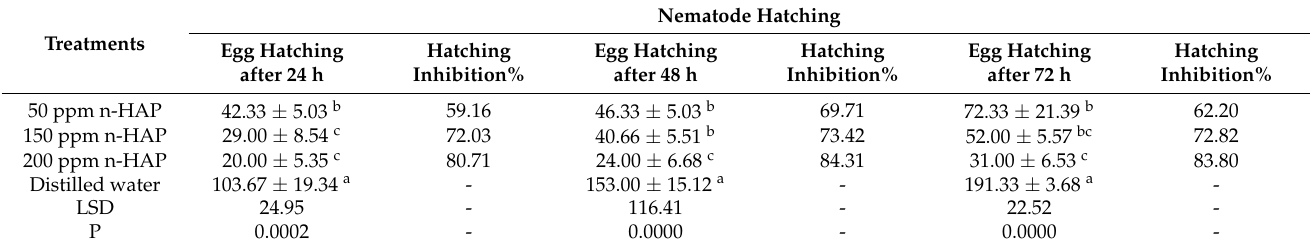
Table 1. Effect of n-HAP on egg hatching of Meloidogyne incognita in vitro.